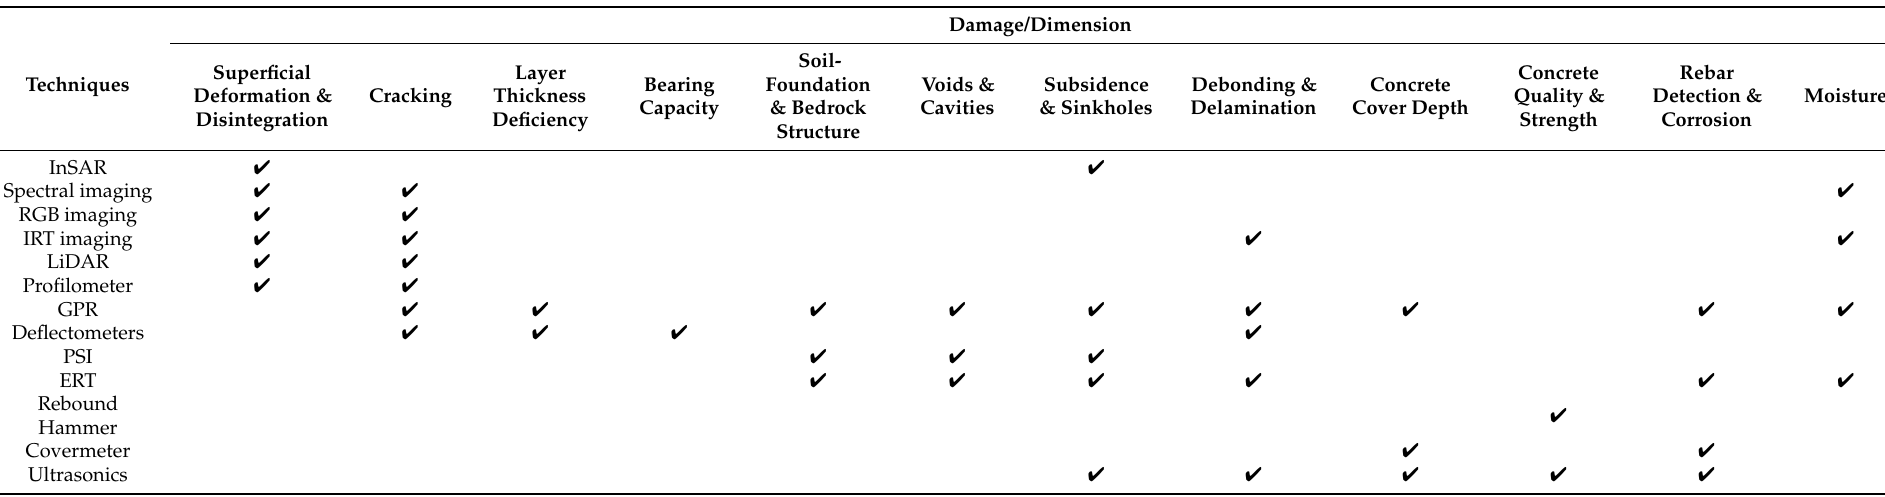
Table 1. Table summarizing the damages and dimensions in pavement assessment for each NDT technique described in this